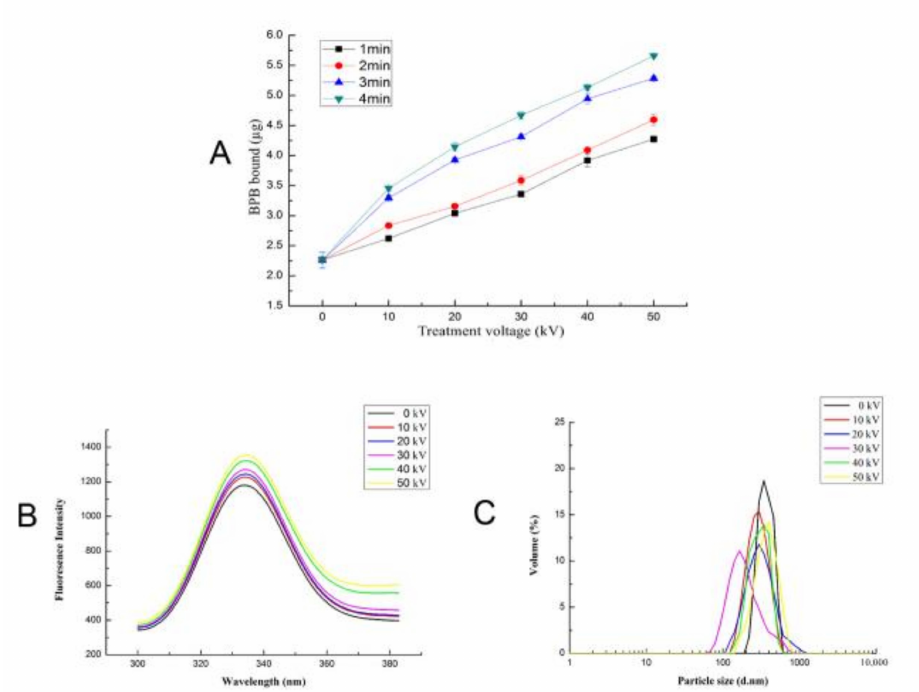
Figure 5. Effect of different ACP treatment voltage and time on surface hydrophobicity ( A ), fluores- cence intensity ( B ), and particle size distribution ( C ) of trypsin (mean ± SD, n = 3). Control (0 min) refers to samples without ACP